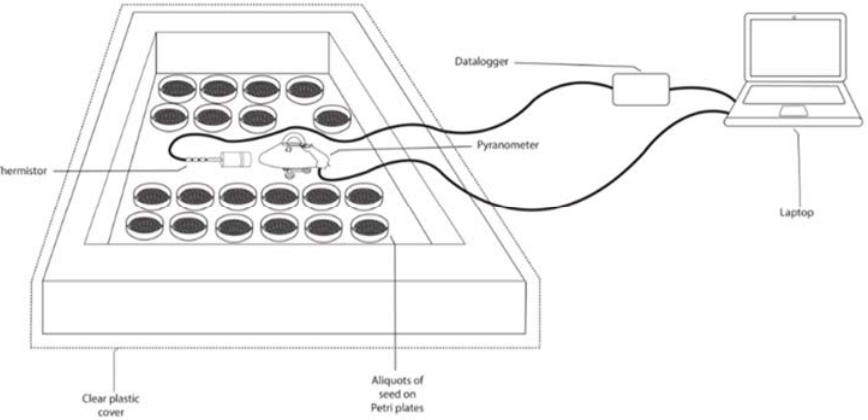
Figure 3. UV-B radiation solar oven schematic representation to treat Andean lupin seed lots infected with anthracnose. Source: [56].